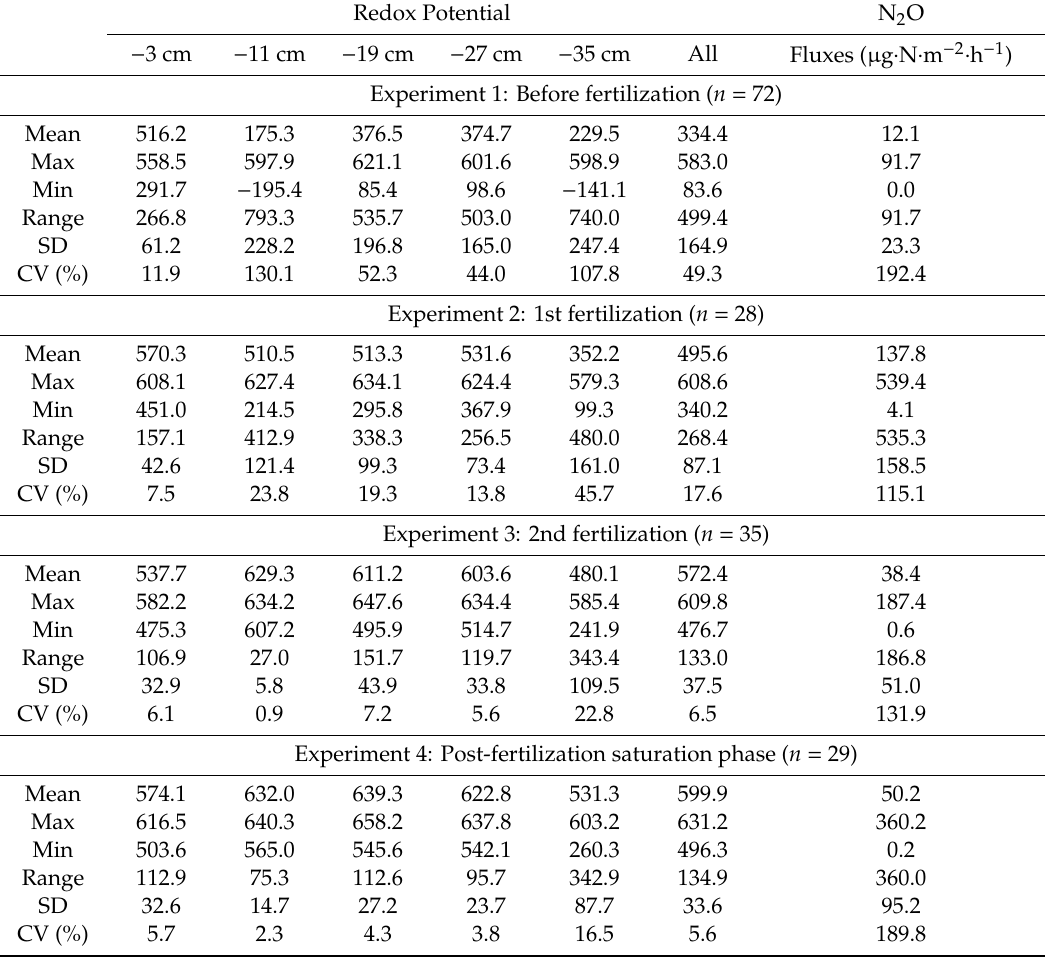
Table 1. Mean, maximum, and minimum daily soil redox potential values and N 2 O fluxes. In addition, the range, standard deviation (SD) and the coe ffi cient of variation (CV) are